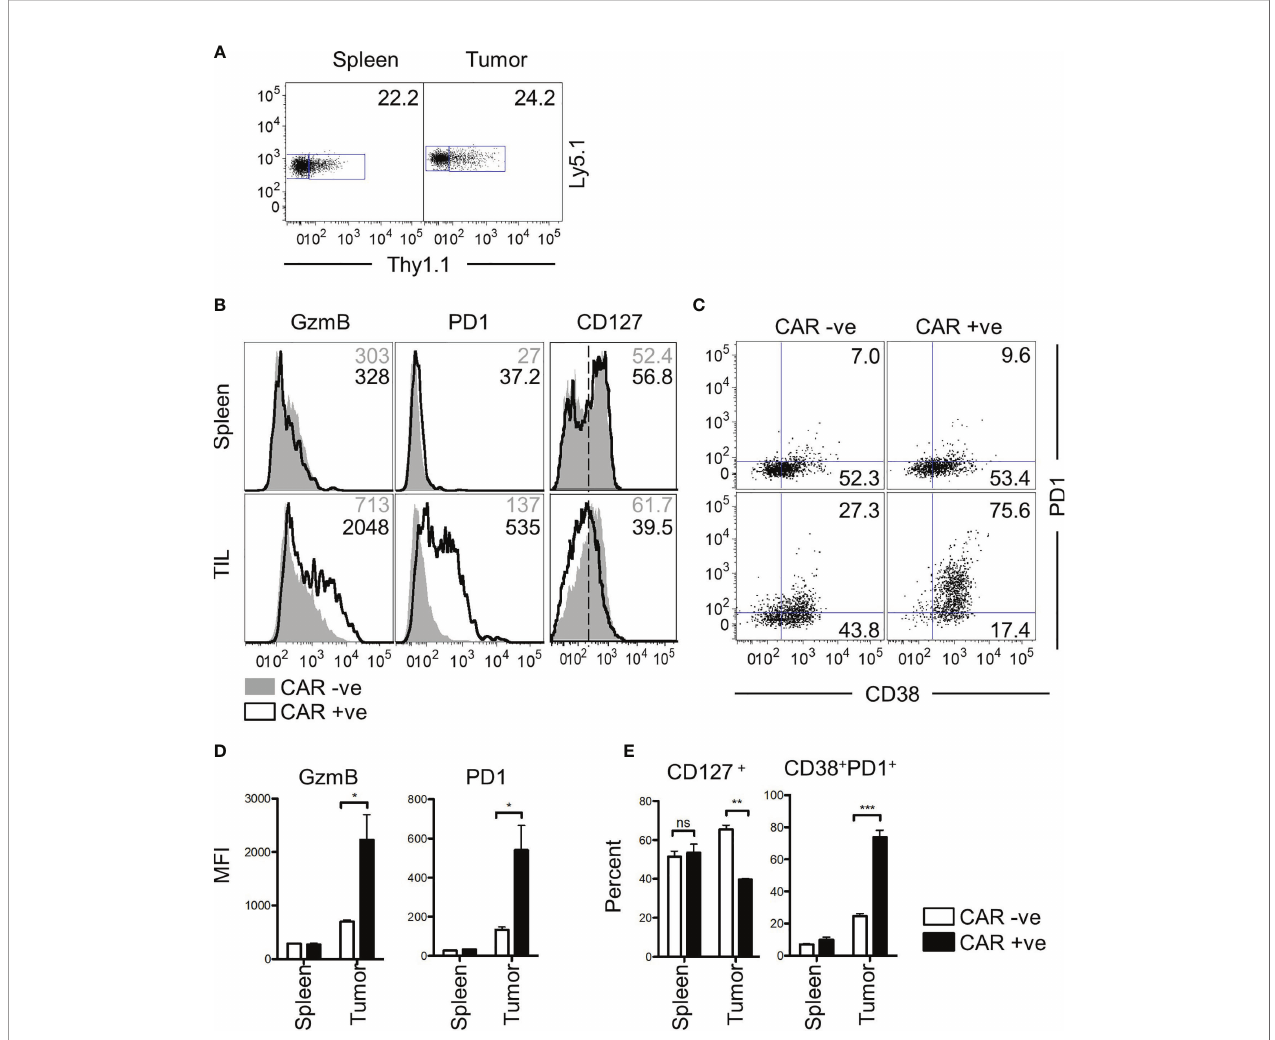
FIGURE 6 | Bystander CD8 T cells are functional in a CAR T therapy mouse model. (A) CD8 T cells transduced with a CD19 CAR and Thy1.1 transduction marker are observed in both spleen and tumor of mice at day 25 post transfer. Donor cells express Ly5.1 and CAR transduced cells express Thy1.1. (B) Phenotypic markers GzmB, PD-1, CD127, and (C) CD127 vs CD38 were assessed by fl ow cytometry. Values for GzmB and PD-1 show MFI, whereas the numbers for CD127 and CD38 v PD-1 show percent gated positive or double positive. GzmB and PD1 markers are graphed below in (D) CD127+ and CD38+PD1+ are graphed in (E) All data is representative of two independent repeats with N=3 mice per group. ns, non-signi fi cant. *p < 0.05, **p < 0.01, ***p < 0.001 as determined by paired